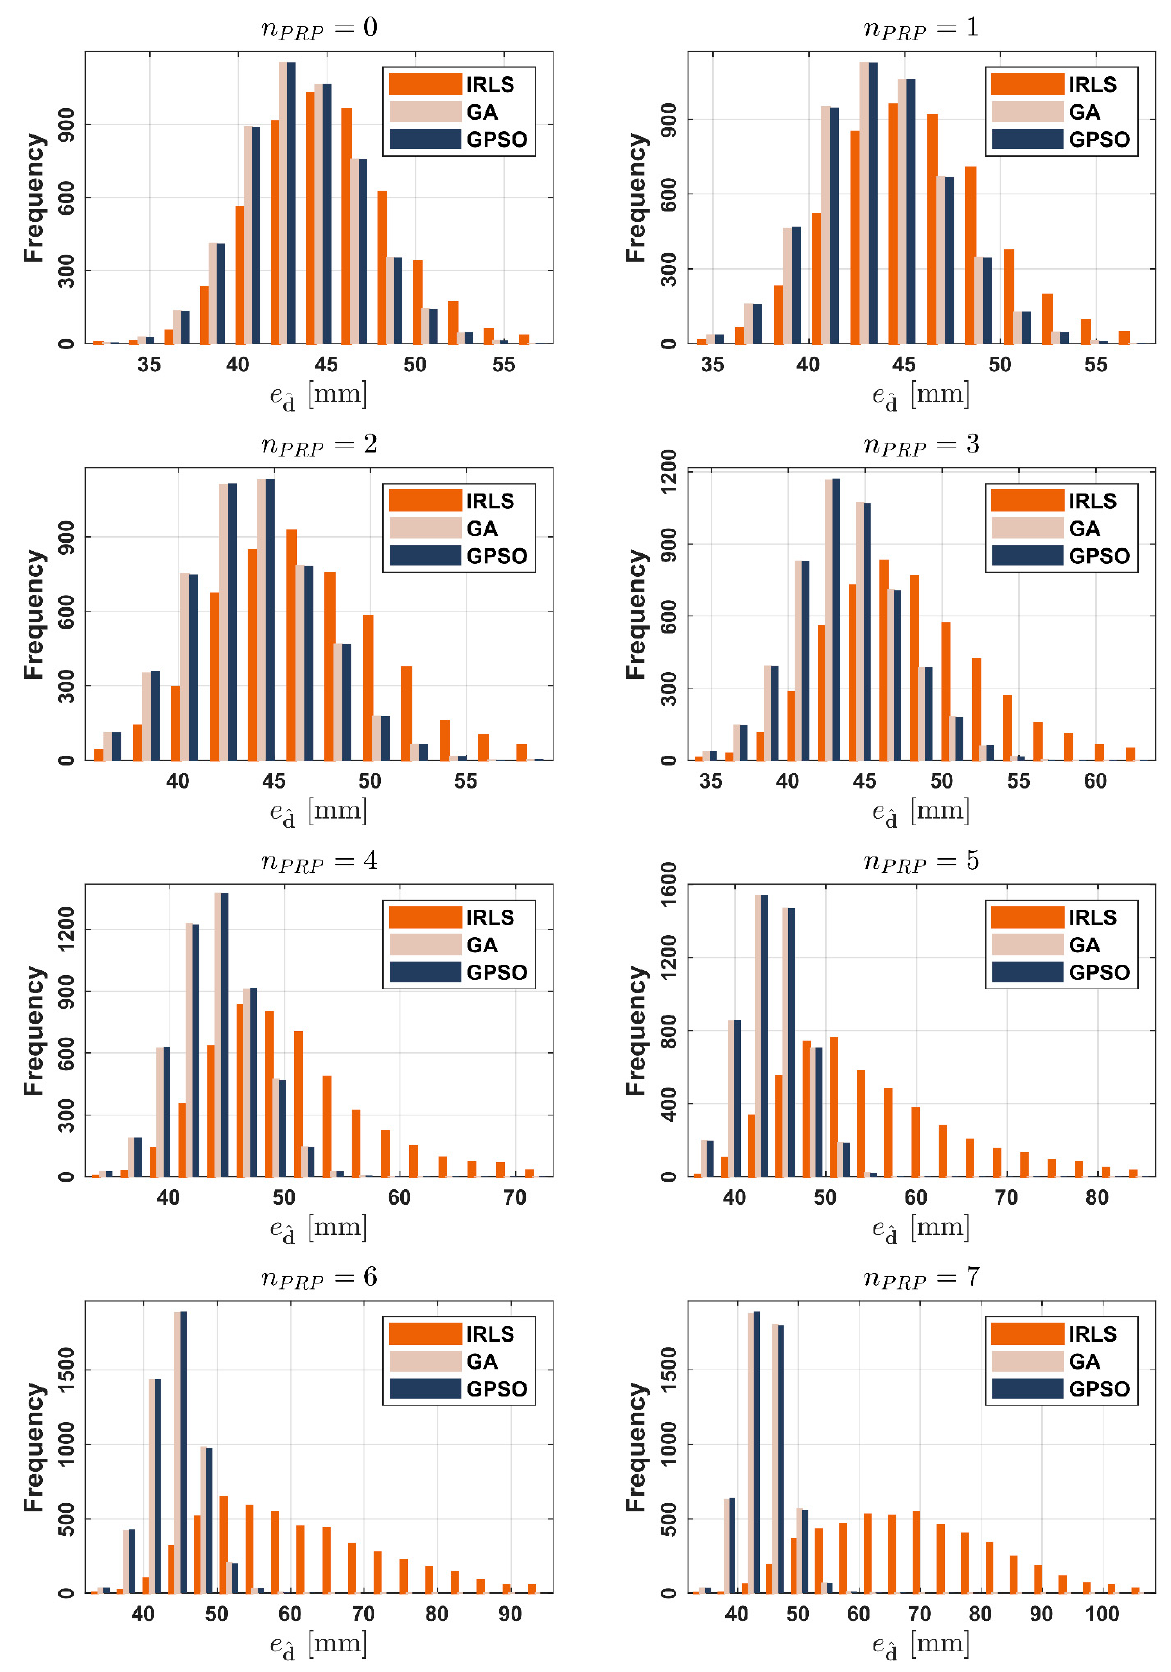
Figure A3. Empirical distributions of overall absolute true errors 𝑒 𝐝(cid:4632) for variant 3.